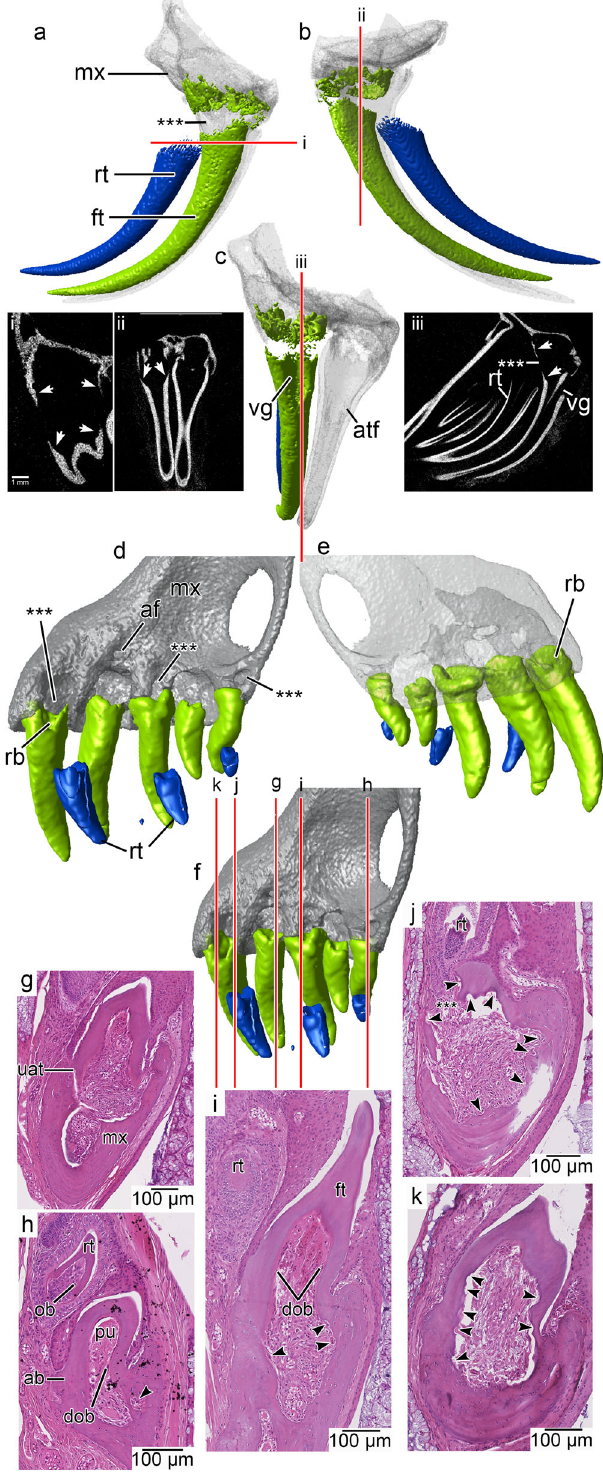
Fig. 3| Toothresorptioninthevenomfang oftheviperid Crotalusatrox andin the scolecophidian snake Anilios bicolor . a CT-segmented model of a maxilla of Crotalusatrox showingthenear-sheddingstageofavenomfanginlateral, b lingual, and c anterior views.The old functionalfang isin green, the replacement fang isin blue. CT slices in various angles show how internal resorption has allowed for the controlled detachment of the old fang from its base (i – iii). The neighboring func- tional fang is undisturbed in the process. d CT-segmented model of a maxilla of Anilios bicolor showing teeth at various stages in the replacement cycle in lingual (functionalteethingreen,replacementteethinblue); e labial, and f posterolingual views to visualize large resorption structures in the maxilla (asterisks) and their relationships to the teeth. g Coronal section of a new tooth that is attached to the maxilla by non-mineralized attachment tissues. h Ankylosed tooth in which the internal portion of the base of the tooth has begun showing signs of resorption (arrow) while the replacement tooth is still a distance away from the functional tooth base. Note the well-developed odontoblasts in the replacement tooth com- pared with the degenerated odontoblasts within the functional tooth. i Ankylosed tooth showing appearance of larger macrophages and early signs of resorption